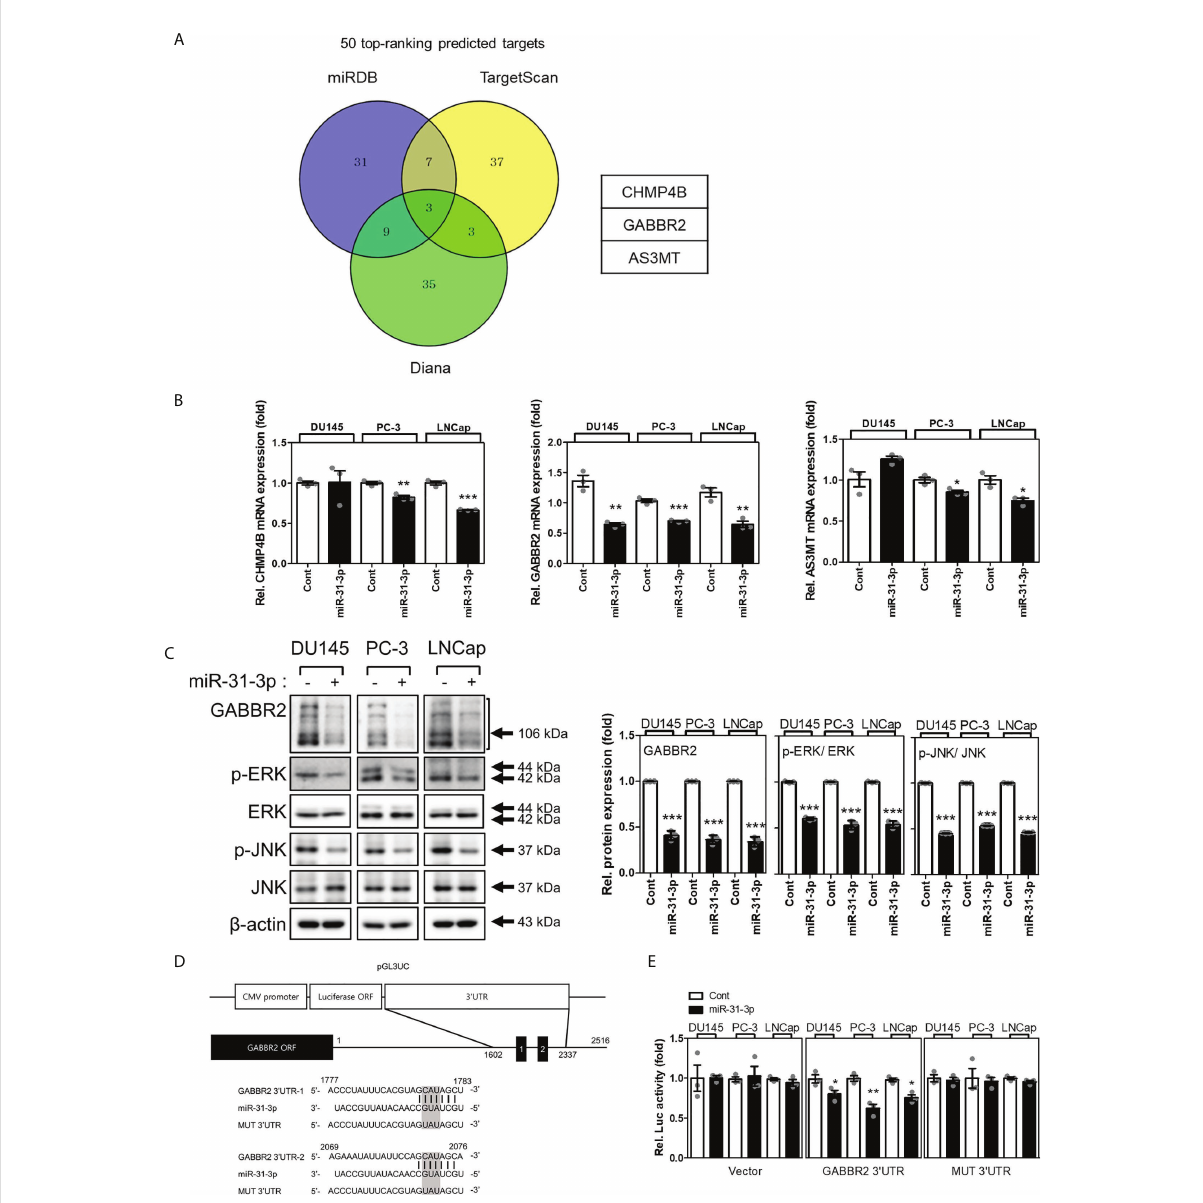
FIGURE 3 miR-31-3p directly targets GABBR2. (A) Venn diagram showing the putative miR-31-3p targets of the top 50 rankings using algorithms to predict miRNA targets. (B) miR-31-3p downregulates GABBR2 mRNA expression. Glyceraldehyde 3-phosphate dehydrogenase was used as the reference gene for normalization. An unpaired two-tailed Student ’ s t -test was used to calculate P values. Error bars represent mean ± standard error of the mean (SEM). *P value < 0.05, **P value < 0.01 and ***P value < 0.001 vs. Cont (n = 3). (C) miR-31-3p suppresses the expression of GABBR2, p-ERK, and p-JNK. An unpaired two-tailed Student ’ s t- test was used to calculate P values. Error bars represent mean ± standard error of the mean (SEM). ***P value < 0.001 vs. Cont (n = 3). (D) Construction of a reporter including the predicted miR-31-3p target sequence in the 3 ′ -UTR of GABBR2 . (E) Reporter assay indicating direct targeting of the 3 ′ -UTR of GABBR2 by miR-31-3p. Renilla luciferase activity was used as a reference plasmid to normalize fi re fl y luciferase activity. An unpaired two-tailed Student ’ s t -test was used to calculate P values. Error bars represent mean ± SEM. *P value < 0.05 and **P value < 0.01 vs. Cont (n =